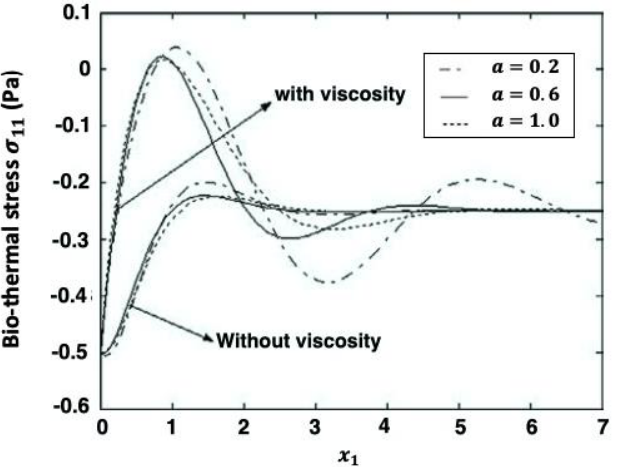
Figure 2. Biothermal stress σ 11 wave fluctuations along x 1 –axis for different values of the fractional parameter.